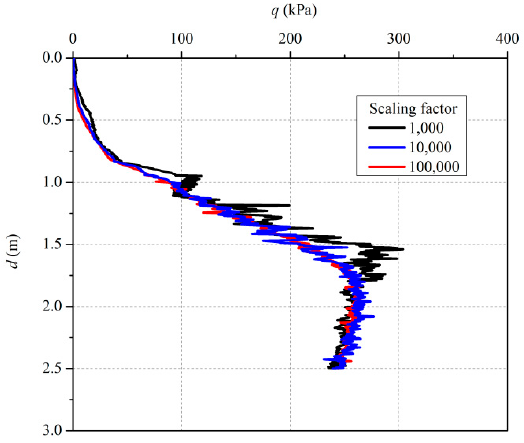
Figure 6. Penetration resistance profiles for different mass scaling factors.